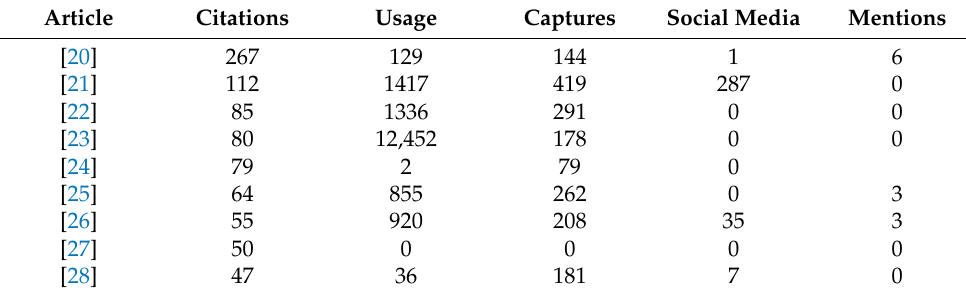
Table 2. Ranking of articles per citation.